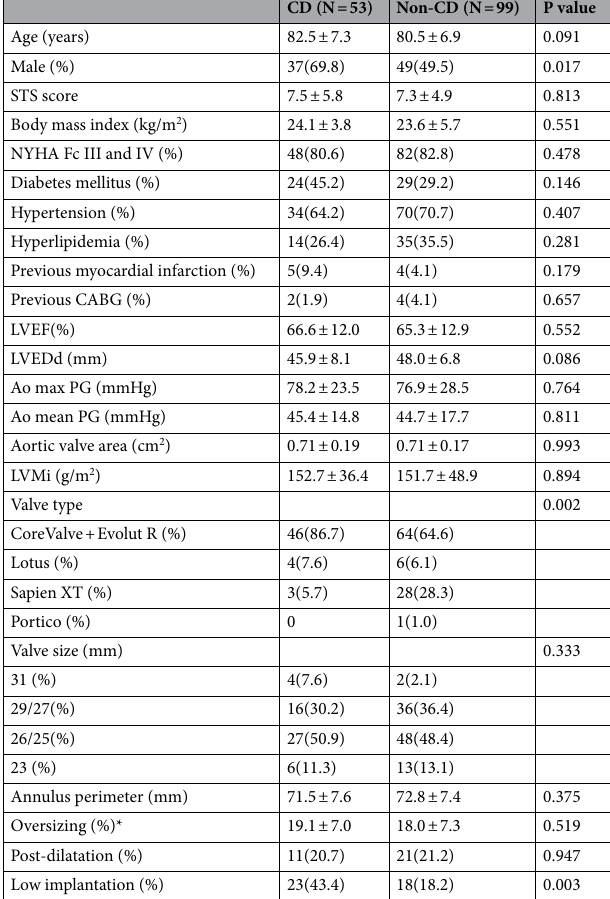
Table 1. Baseline characteristic and procedural variables according to CD after TAVR. Mean ± SD are shown. CD conduction disturbance, CABG coronary artery bypass graft surgery, STS society of thoracic